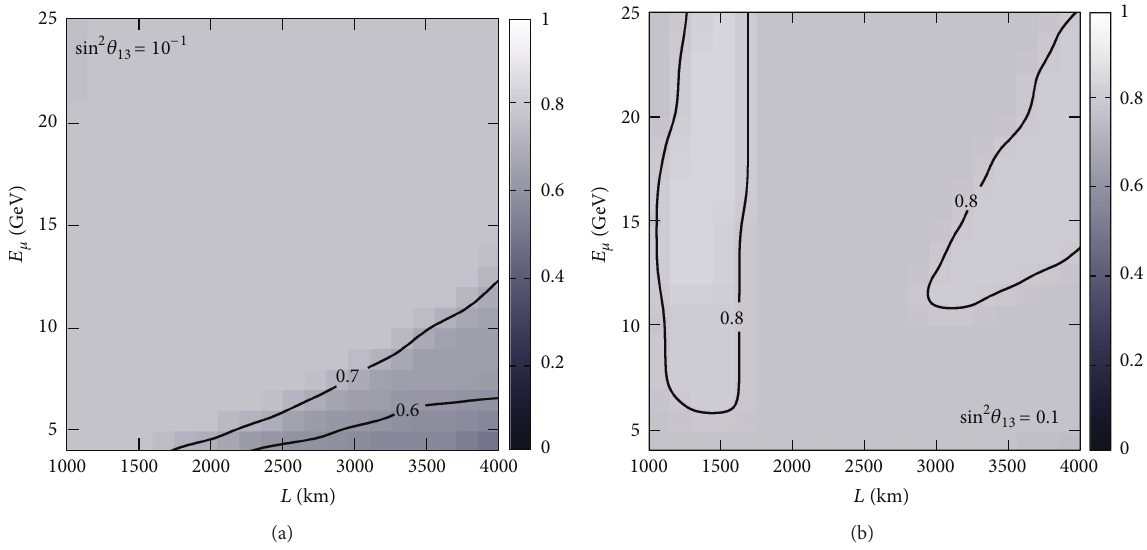
Figure 18: CP violation discovery at 3𝜎 fraction as a function of baseline, 𝐿 , and stored-muon energy using the TASD detector (a) and LAr one with optimistic performance (b). The lines indicate the fraction of values of 𝛿 for which sensitivity can be achieved. Further details can be found in [148] from which the figures have been taken. Table 3: The seven potential locations for an underground neutrino observatory under consideration in the LAGUNA Design Study: the distance from CERN and the energy of the first oscillation maximum, in the absence of matter effects, are given. From [106]. Location Distance from CERN